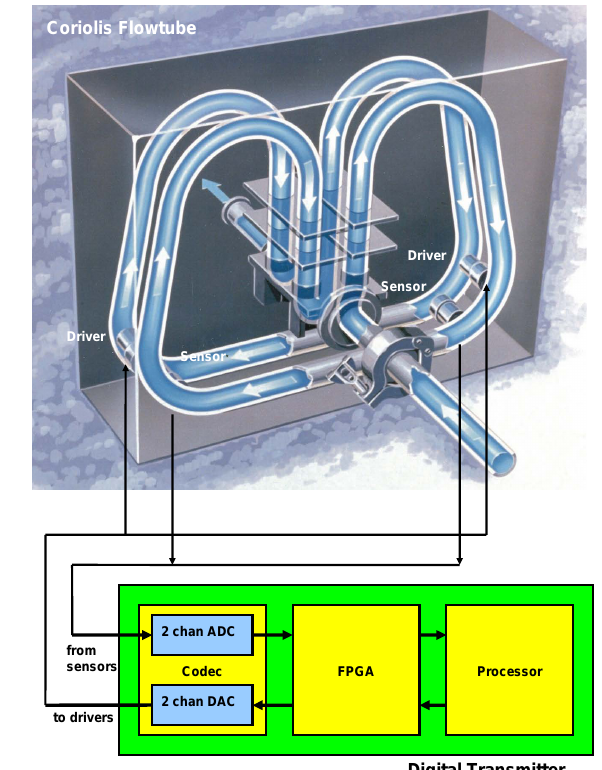
Figure 1. Coriolis mass flow meter: flowtube and digital transmit- ter.